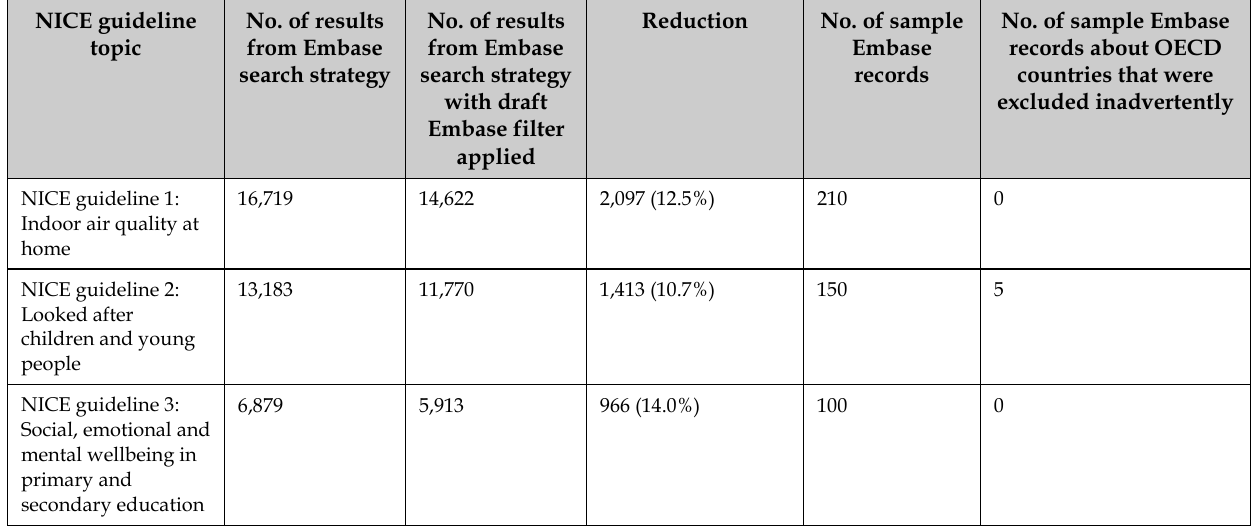
Table 2 Draft NICE Embase OECD countries filter results NICE